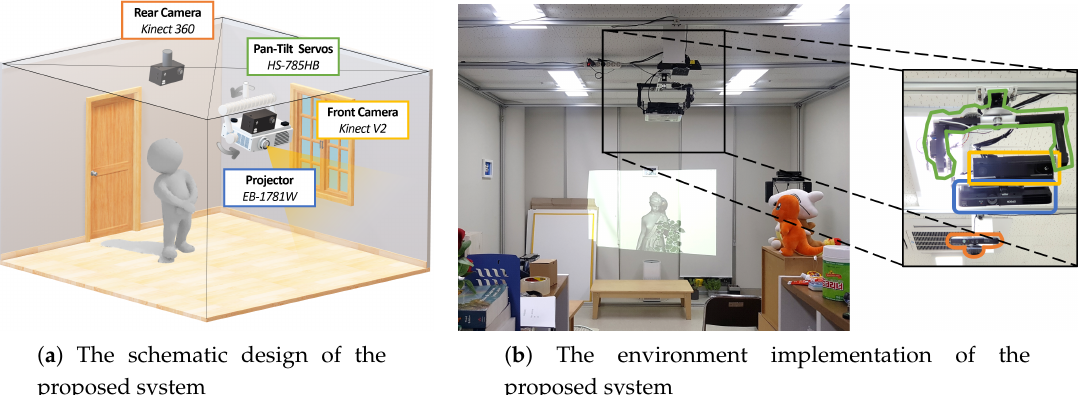
Figure 1. The environment setup of the proposed system. The front camera for capturing geometry data and the projector are mounted on the pan–tilt platform, all of which are installed in the middle of the room. The rear camera is installed in the far back to have a wide view of the environment to track and interact with the user. Each component in the images is color-coded—best viewed in